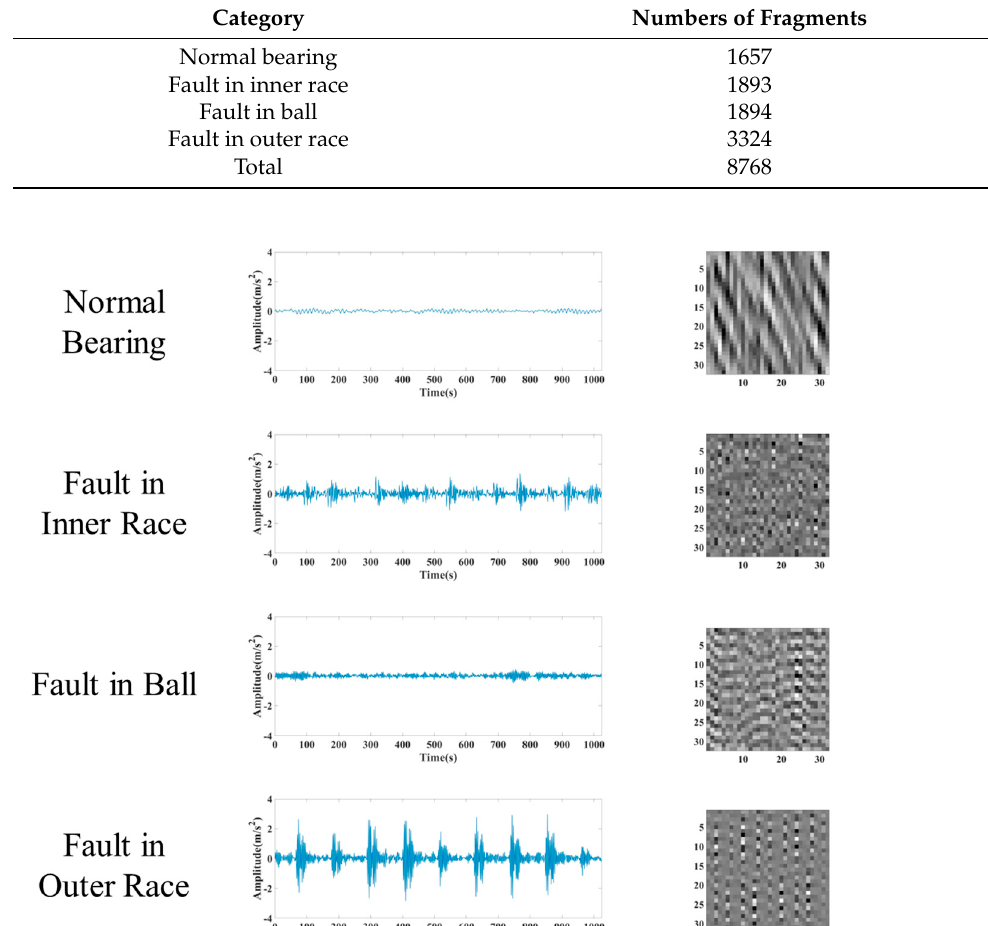
Table 1. Total number of fragments in each category.